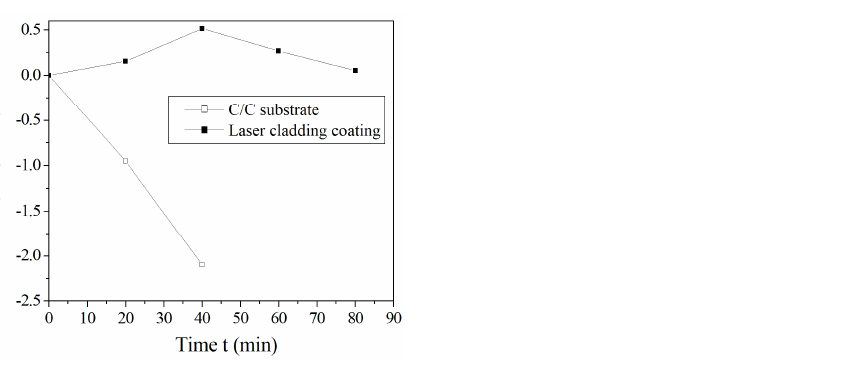
Figure 5. Weight gain curves of C/C matrix and laser cladding coating after oxidation at 1600 °C and at different time.